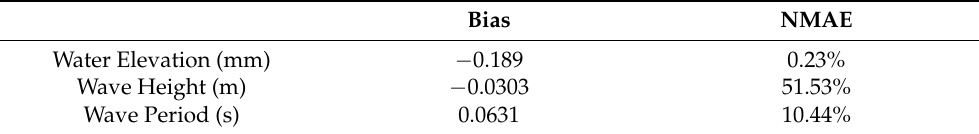
Table 3. Average Bias (AB), Equation (11), and Normalized Mean Absolute Error (NMAE), Equation (12), for the S2 fine mesh model of each MMEMS ensemble member. Values are aver- aged across all nodes, and all timesteps during the wind